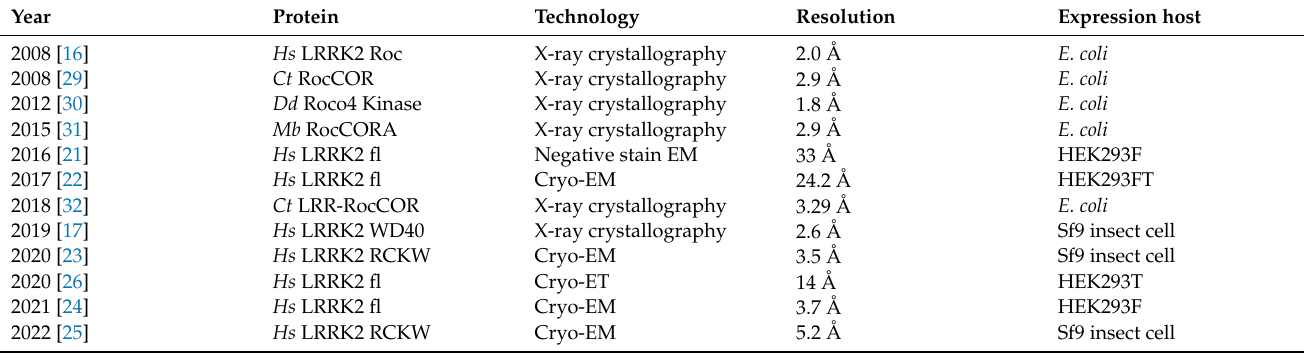
Table 1. Published LRRK2 and Roco structures. Hs ( Homo sapiens ), Ct ( Chlorobium tepidum ), Dd ( Dictyostelium discoideum ), and Mb ( Methanosarcina barkeri